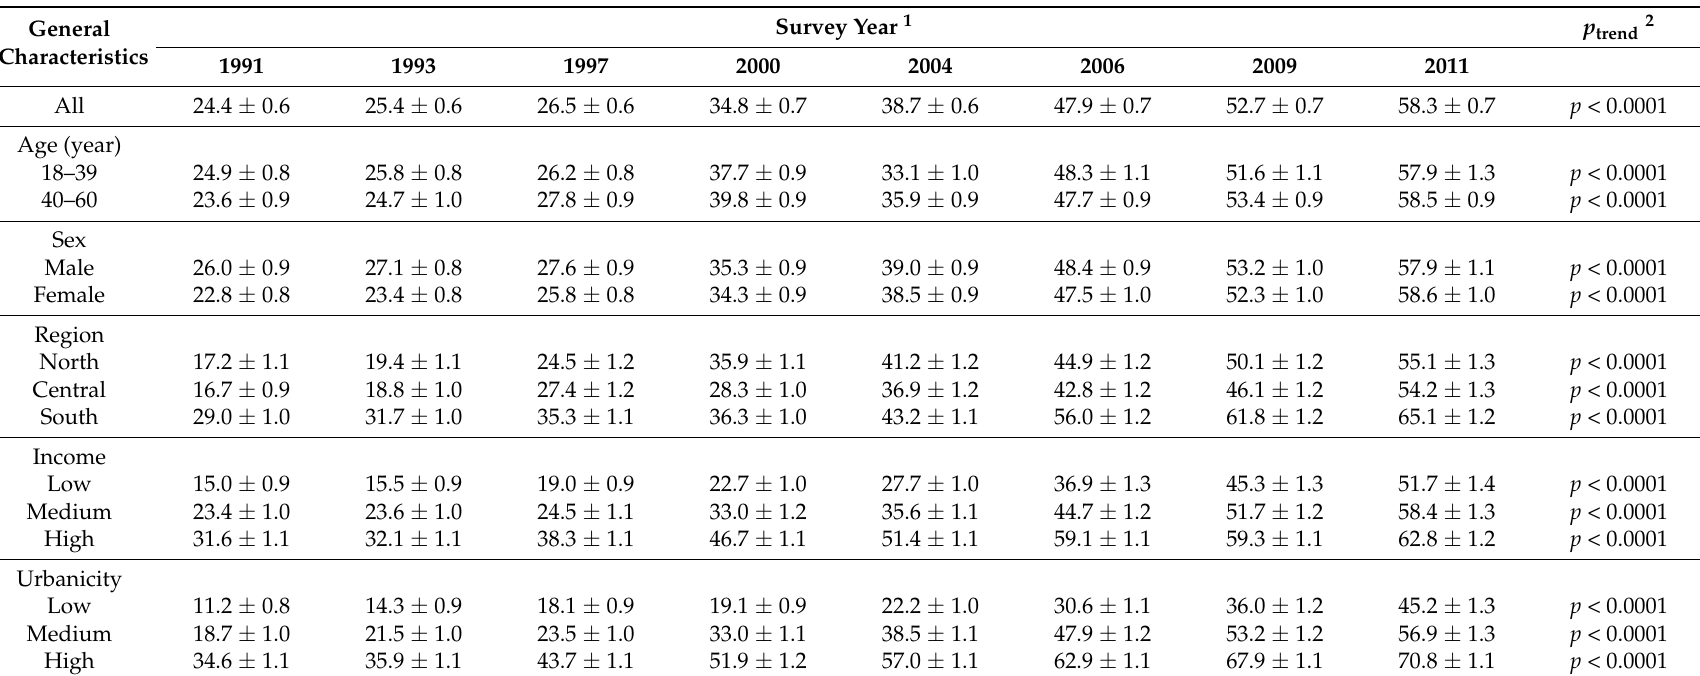
Table 5. Proportions of Chinese rural adults having more than 30% energy from fat from 1991 to